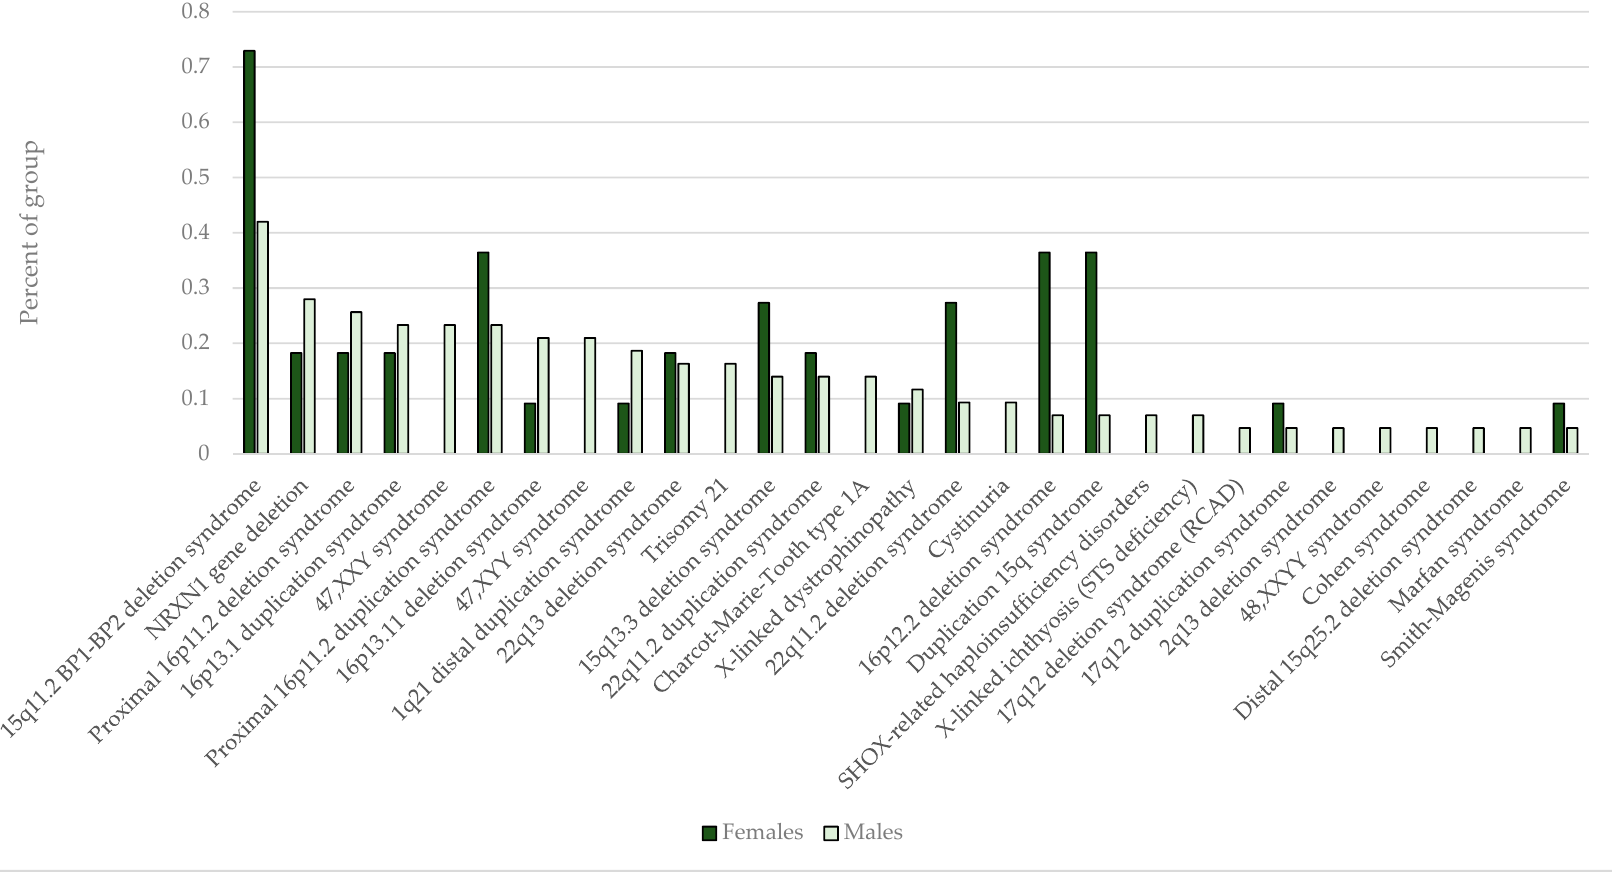
Figure 3. Frequency of diagnoses for combined ASD group by gender. Total females = 2929; total males =